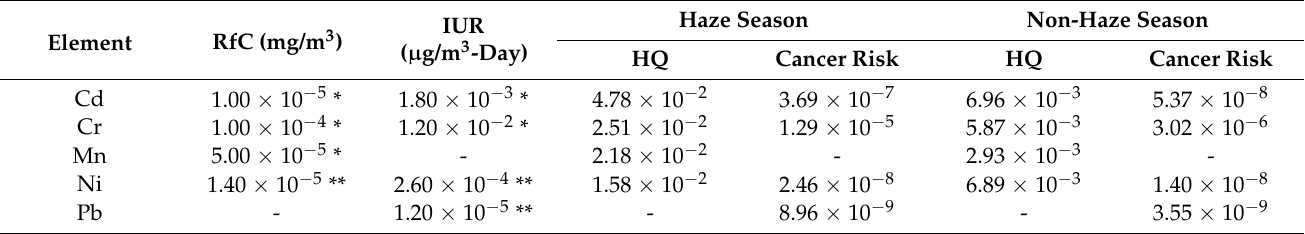
Table 4. The average HQ and cancer risk from elemental composition in PM